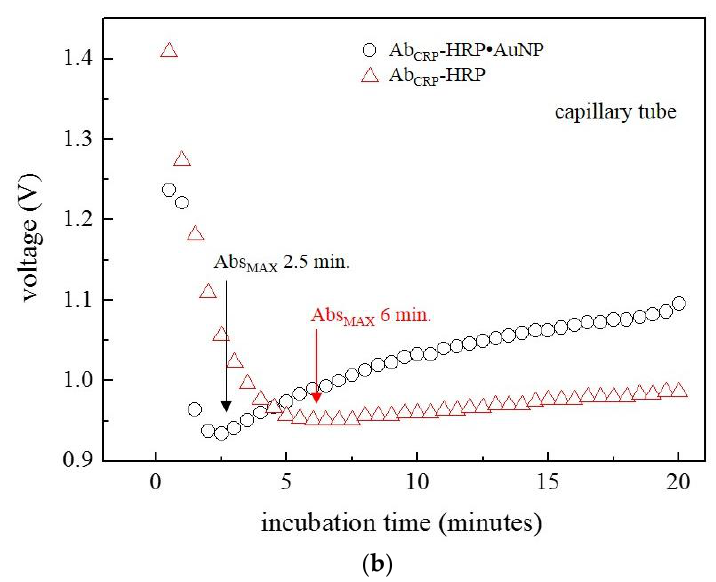
Figure 7. Plots representing the monitoring of the ELISAs either on ( a ) the 96-well plate, or ( b ) the capillary tube using AuNP • antiCRP-HRP (black circle) and antiCRP-HRP (red triangle) as indicator antibodies.